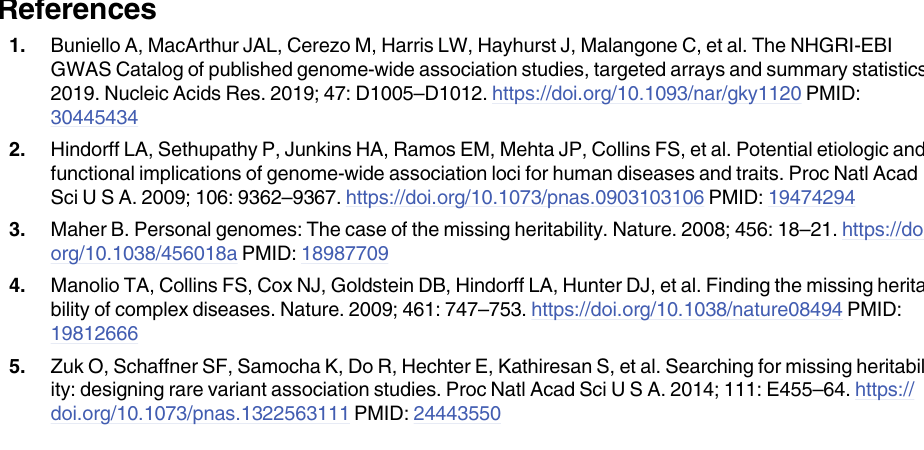
S6 Table. RV eGenes and genes with p-values < 1e-4 from LRT-q before and after regress- ing out common eQTLs. S7 Table. RV eGenes and genes with p-values < 1e-4 from SKAT-O before and after regressing out common eQTLs. S8 Table. Summary statistics of 49 GTEx